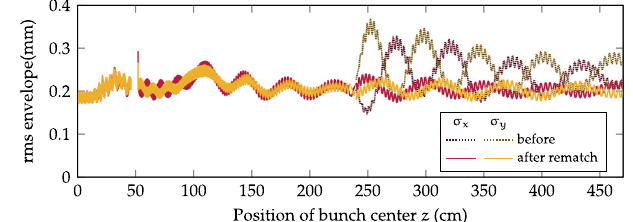
FIG. 23. Beam envelopes of the Carbon-RFQ split into two cavities before and after the rematch.